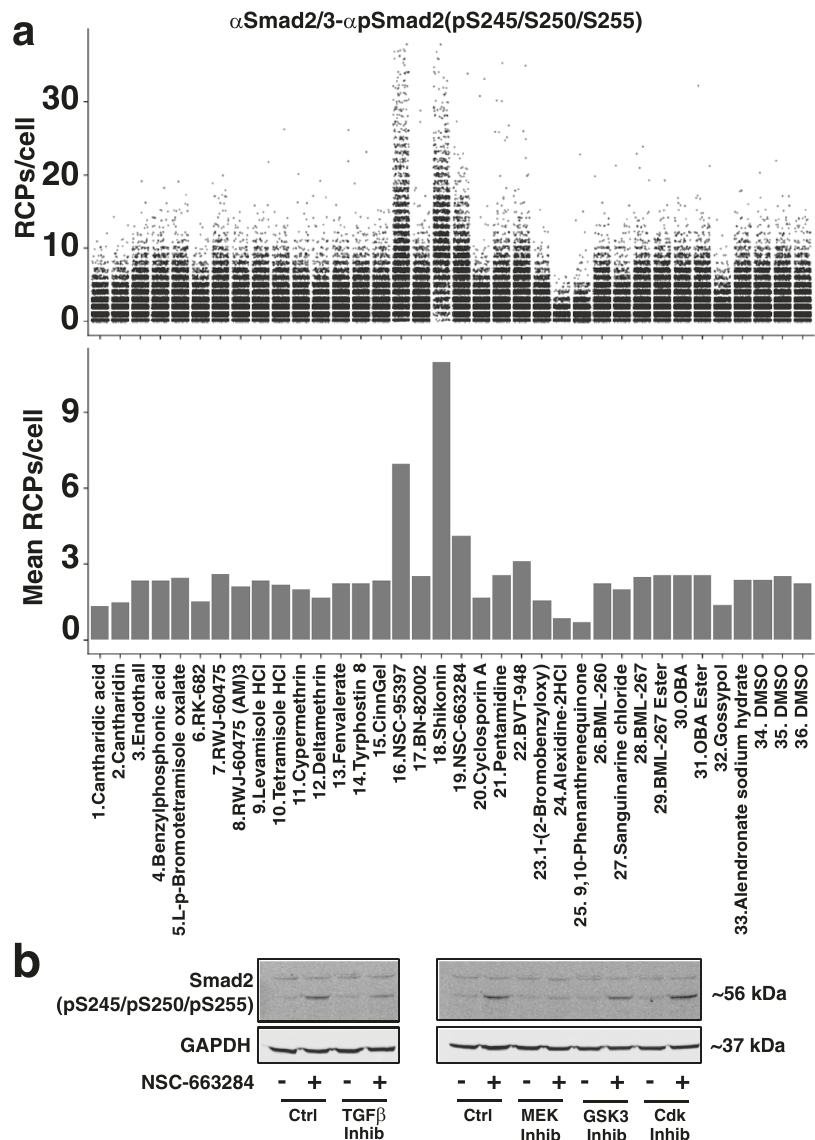
Fig. 5 Effects by members of a library of 33 phosphatase inhibitors on Smad2/3-Smad2(pS245/pS250/pS255) levels in HaCAT cells. a HaCAT cells were treated or not with 10 μ M of the indicated phosphatase inhibitors for 4 h before fi xation, isPLA, and imaging. Displayed as individual cells plotted according to their numbers of Smad2(pS245/pS250/pS255) RCPs/cell (top), or as bar graphs showing mean RCPs/cell for each sample. b Western blots for HaCAT cells treated with or without the inhibitor NSC-663284 and with or without the speci fi c pathways inhibitors (TGF- β inhibitor (GW6604), MEK inhibitor (U0126), GSK3 inhibitor (SB-216763), or Cdk inhibitor ( fl avopiridol)) to block potential endogenous signal transduction. The blots display levels of Smad2(pS245/pS250/pS255) (top panel) and the housekeeping gene GAPDH as control (bottom panel). Full western blot scans are included in supplemental Fig.